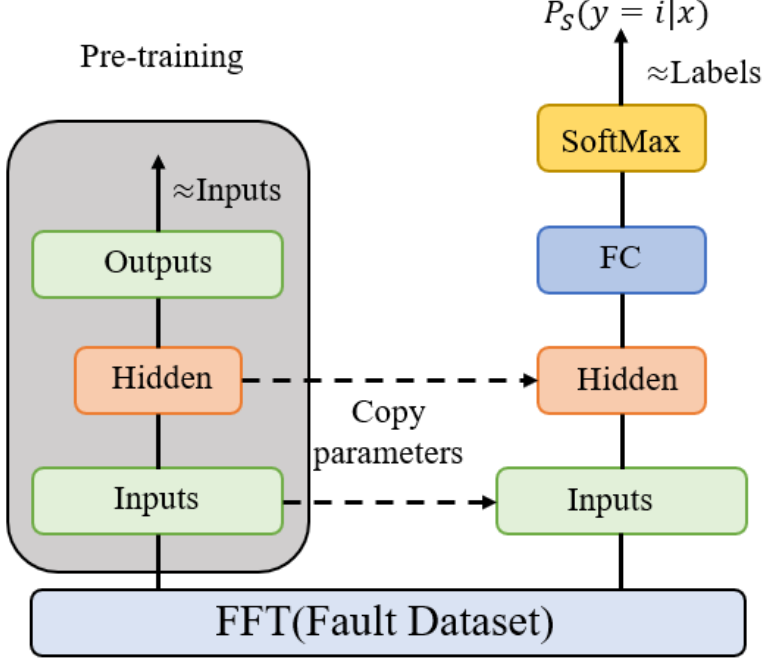
Figure 3. The sparse auto encoder neural network is based on FFT. The input data with FFT will still be combined with fault features and vibration frequencies. At this time, the sparse auto encoder can obtain better low-dimensional features, and further improve the diagnostic